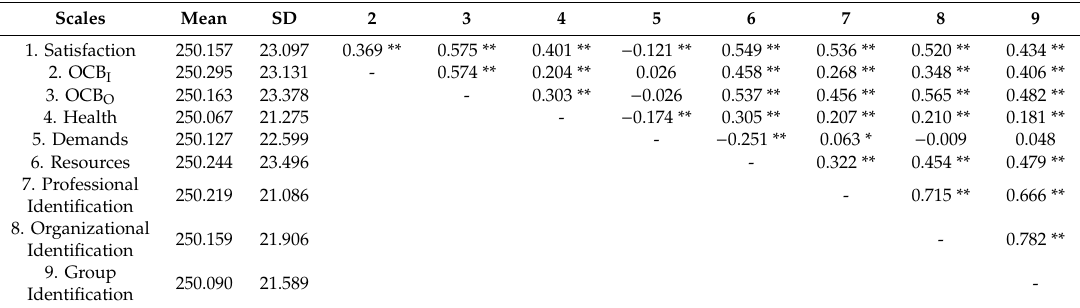
Table 1. Means, standard deviations, and employee-level correlations ( n = 1579).